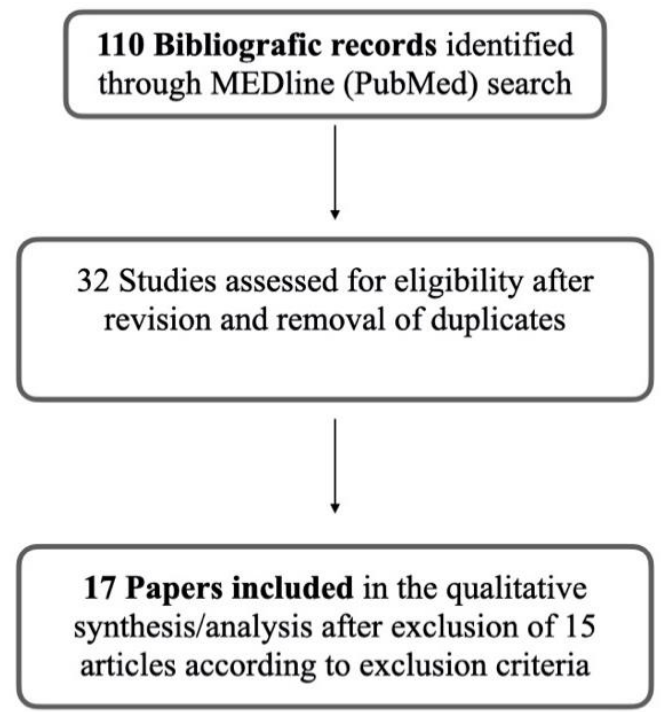
Figure 1. Study selection